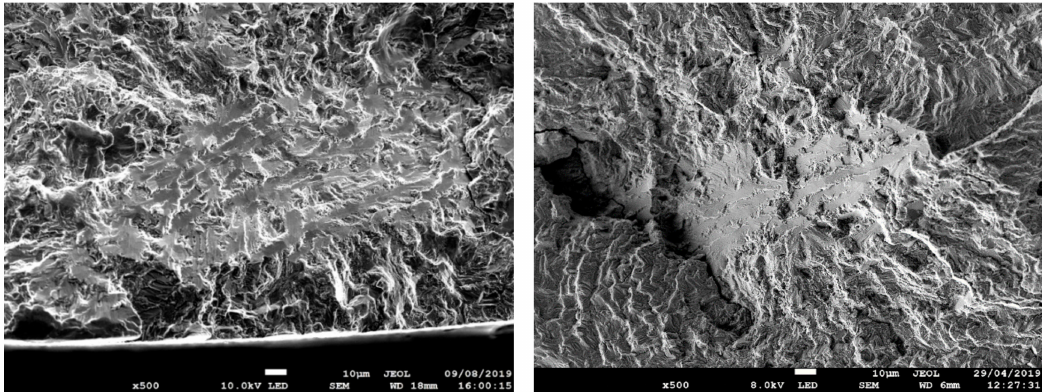
Figure 8. Facet clusters initiating surface ( left ) and sub-surface ( right ) failure. Both of these specimens were tested under a peak stress of 575MPa and HCF waveform.